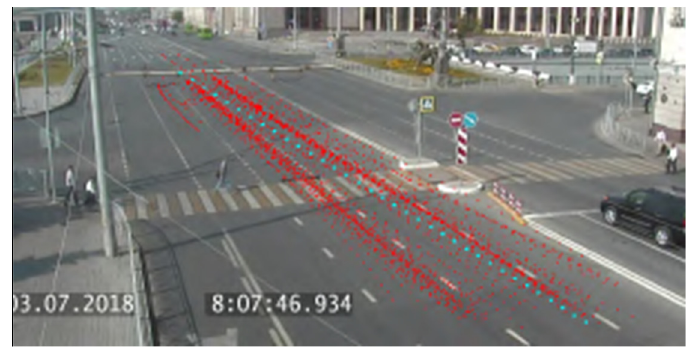
Figure 2. Tracking points.